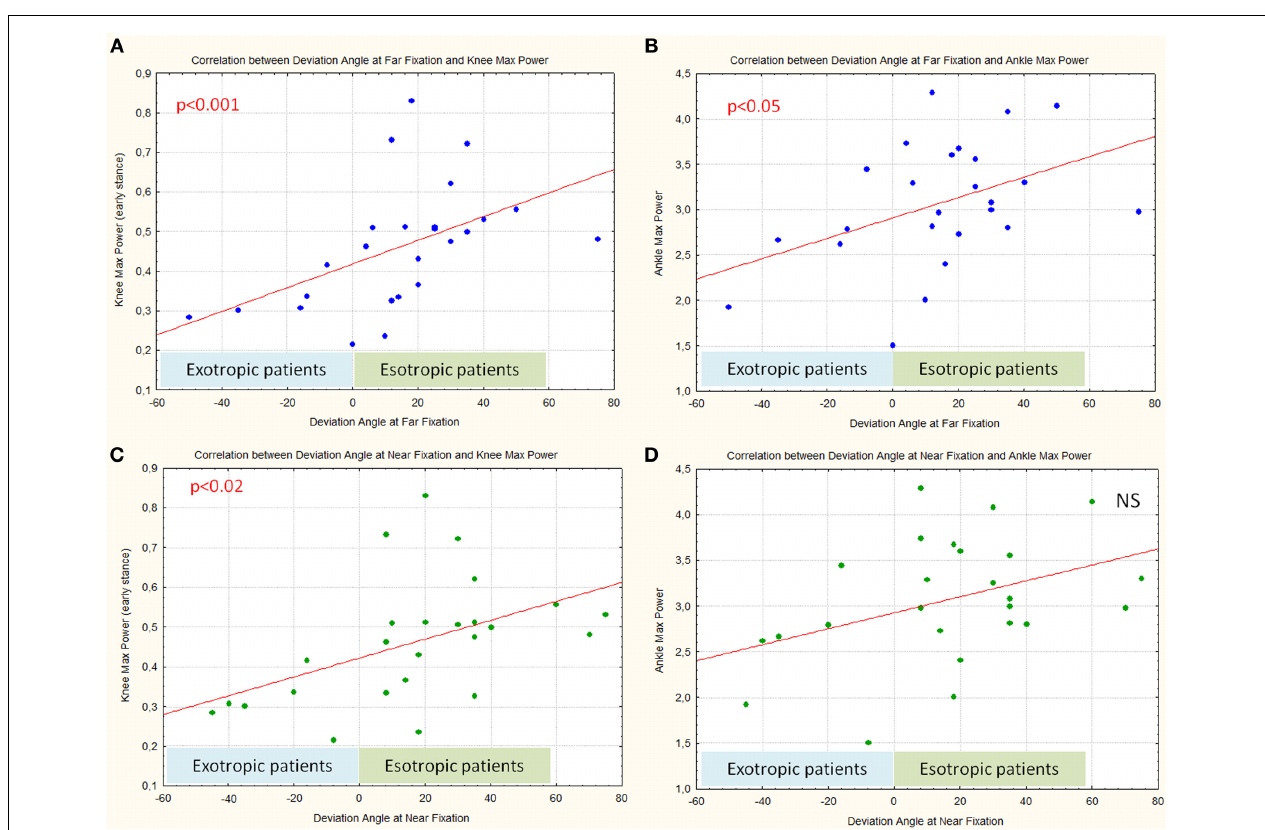
FIGURE 5 | Correlation between deviation angle values at far (A,B) and near fixation (C,D) and Maximal Power at the knee and at the